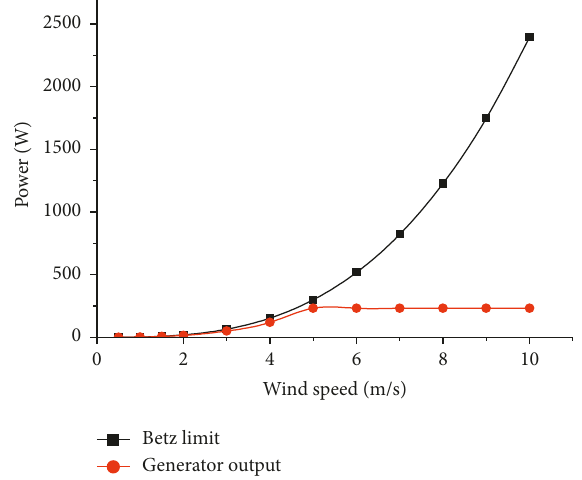
Figure 12: Expected wind turbine generator power